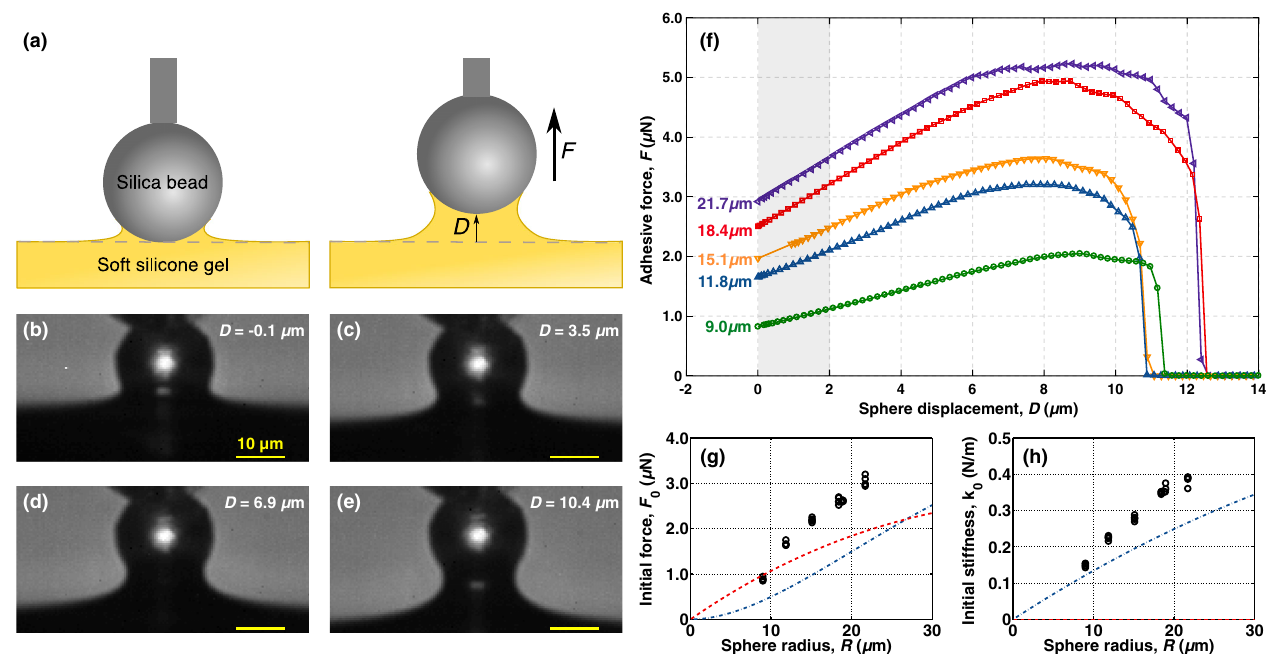
FIG. 1. Structure and force of soft adhesive contacts. (a) Schematic of the experiment. A force F is required to hold the sphere rigidly at each displacement D . (b – e) Raw images of adhesive contact between a 10 . 0 - μ m-radius sphere and an initially flat, compliant silicone substrate with a Young modulus of E ¼ 5 . 6 kPa. (See Ref. [39] for movies of initial contact and quasistatic pull.) (f) Examples of force- displacement measurements for a range of sphere sizes from initial contact through detachment. Sphere radii are labeled. The shaded region indicates the part of the stable contact regime that is fit to measure the initial contact stiffness. (g,h) Initial contact force F 0 and initial contact stiffness k 0 plotted vs sphere radius R , respectively. Elastic contact mechanics predictions [17] are overlaid as blue dot- dashed lines. Simple capillary predictions with a fixed value of surface stress, ϒ ≈ 0 . 02 N = m [11], are plotted as red dashed